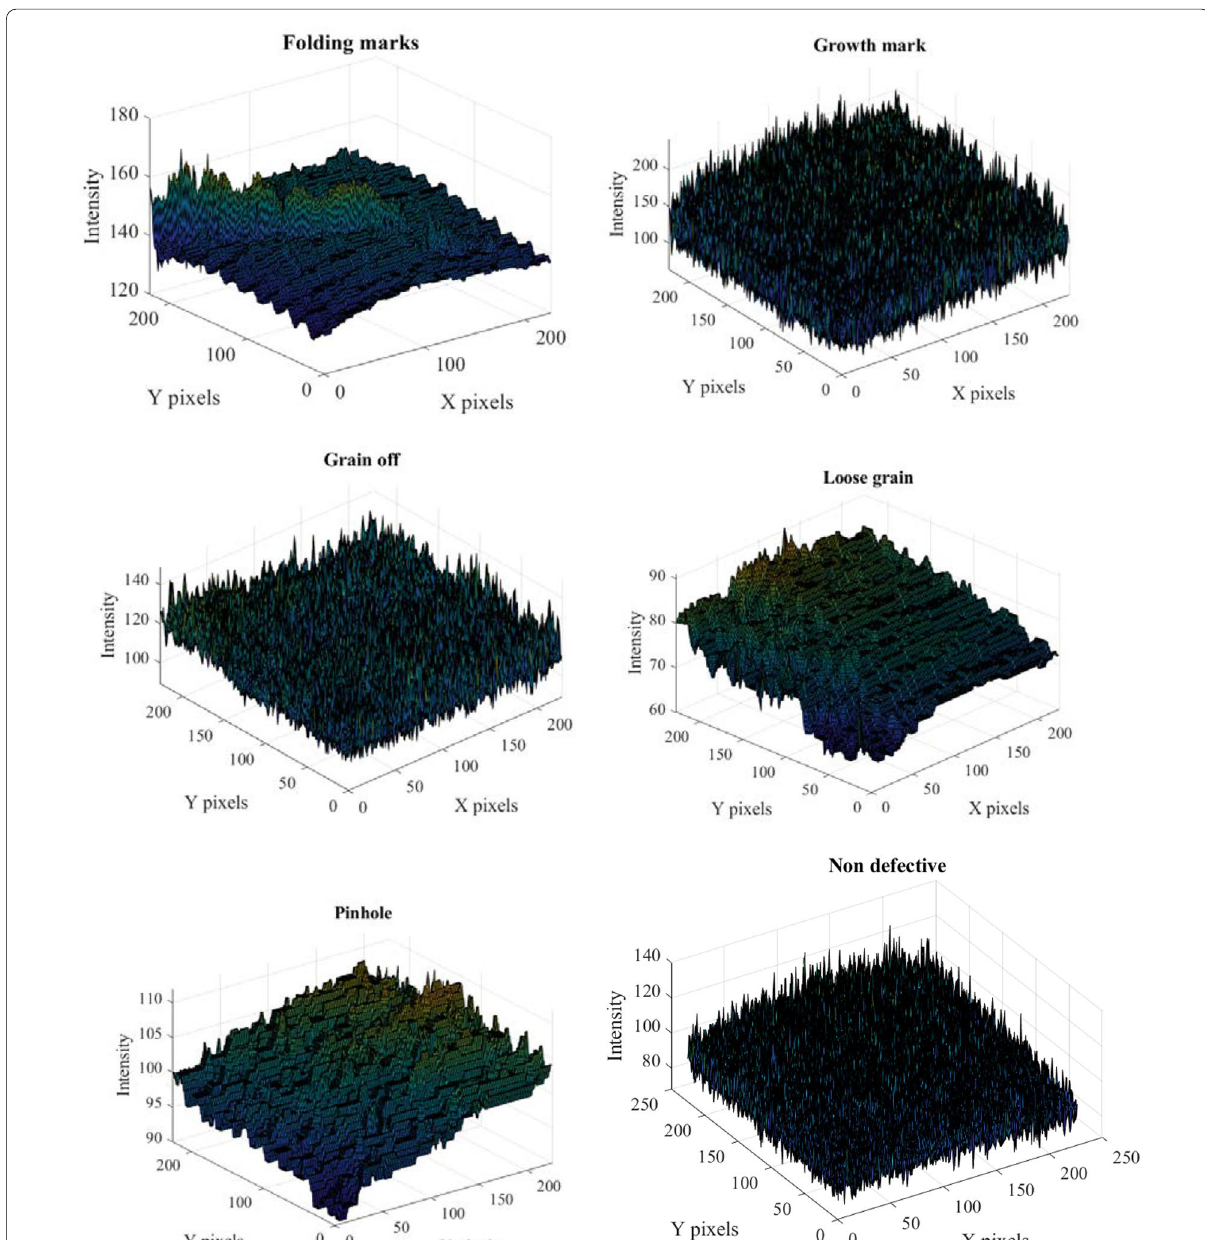
Fig. 3 Gray intensity map of different leather images with different leather